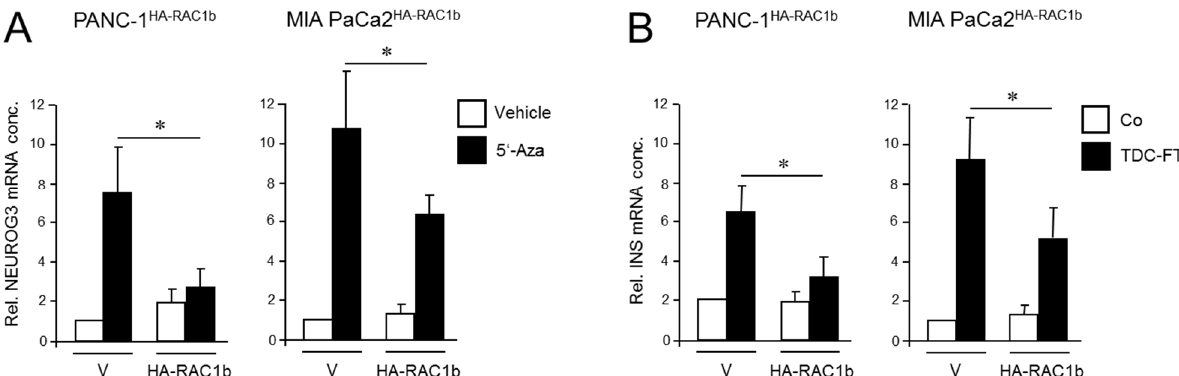
Figure 2. Ectopically expressed RAC1b blocks the conversion of PANC-1 and MIA PaCa-2 cells to cells with a pancreatic endocrine or β cell-like phenotype. ( A ) PANC-1 or MIA PaCa-2 cells with stable or transient expression, respectively, of HA-RAC1b were treated for 3 d with 5’-Aza (1 µM) in standard growth medium followed by another 3 d in growth medium without 5’-Aza. Cells were then subjected to qPCR for NEUROG3 . Data are from three independent experiments and represent the mean ± SD. Asterisks ( ∗ ) indicate a significant difference ( p < 0.05, Wilcoxon test) relative to 5’-Aza-treated empty vector (V) transfected control cells. ( B ) As in ( A ) except that cells were subjected to FT-based TDC towards a β cell phenotype and assayed for INS expression. Control cells received standard growth medium. Data are from three independent experiments and represent the mean ± SD. Asterisks indicate a significant difference ( p < 0.05, Wilcoxon test) relative to V transfected TDC-treated control cells.